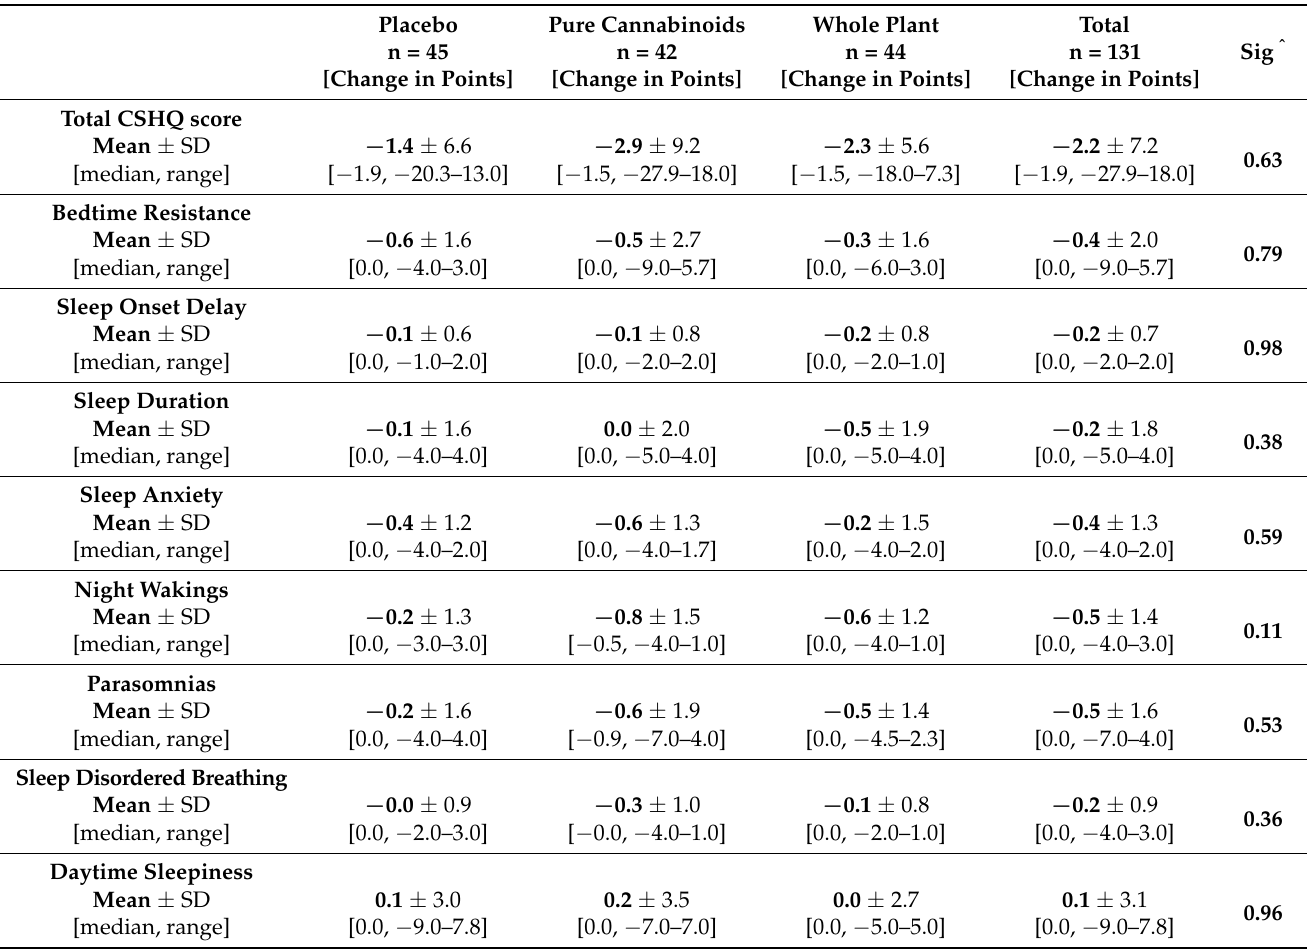
Total n = 131 Sig